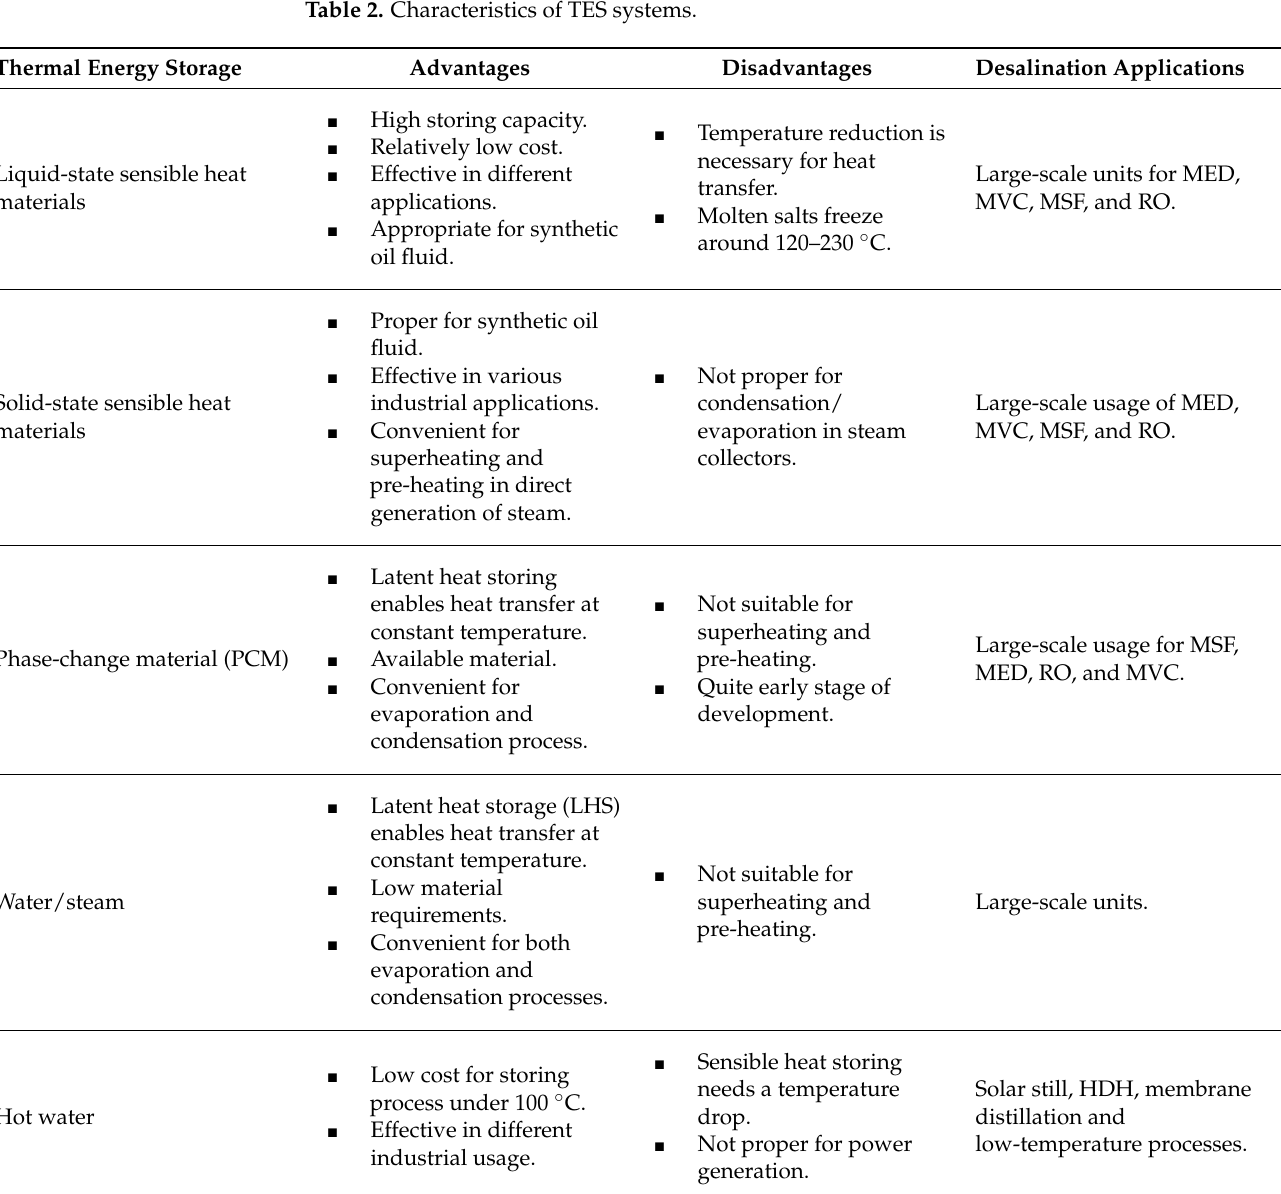
Table 2. Characteristics of TES